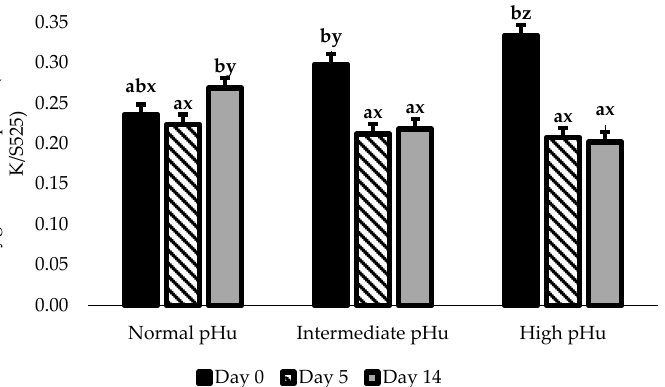
Figure 2. Oxygen consumption, measured as K/S 610/K/S 525) of Nellore Longissimus lumborum steaks with three ultimate pH (pH u ) packaged in HiOx-MAP. ab Difference among days within a pH u range ( p < 0.01). xyz Difference among pH u ranges within an experimental time (day) ( p < 0.01). pH u ranges: normal ( n = 12; 5.40 < pH u < 5.79), intermediate ( n = 12; 5.80 < pH u < 6.19) and high ( n = 12; pH u > 6.20). HiOx-MAP: high oxygen modified atmosphere packaging (80% O 2 /20% CO 2 ). OxyMb: oxymyoglobin -lower value indicates greater OxyMb formed during air-blooming, and then lower oxygen consumption (OC). Standard error bars are